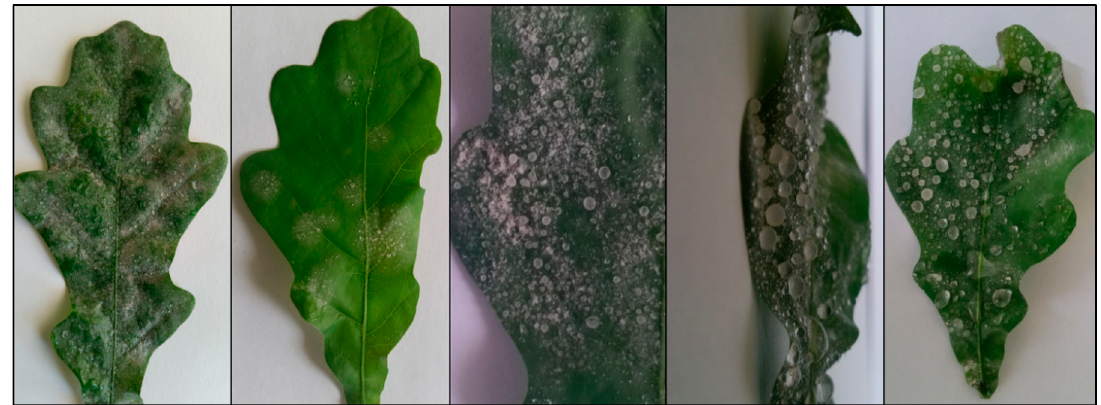
Figure 6. Photographs of raindrops retained on common oak leaves with different degrees of infection with oak powdery mildew.